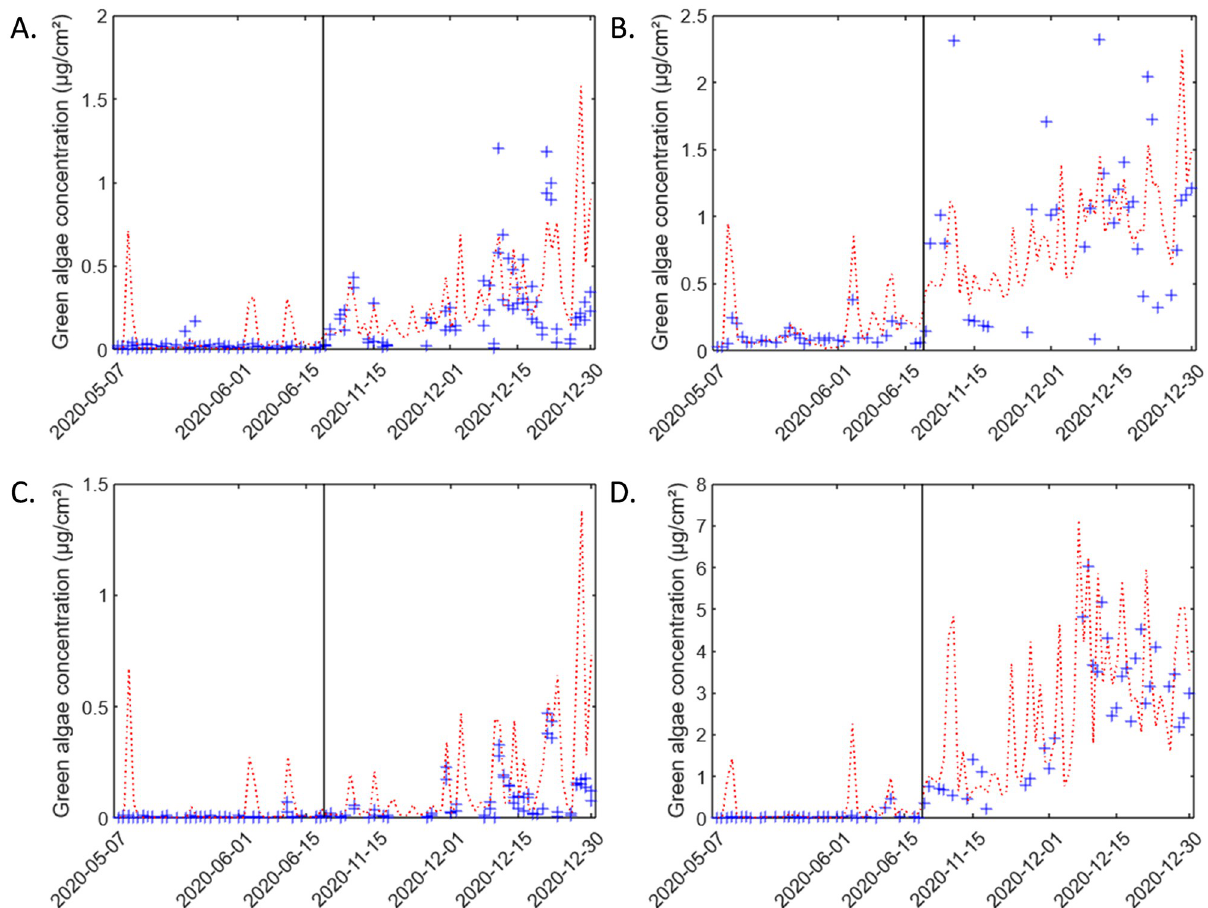
Fig 7. Temporal evolution of green algae concentration. Measured data (blue points) and data calculated using DRF (red line) for each situation: A. VA1 and VA2 (Eq (4)); B. VA3 (Eq (5); C. VNA4 and VNA5 (Eq (6); D. VNA6 (Eq (7)).